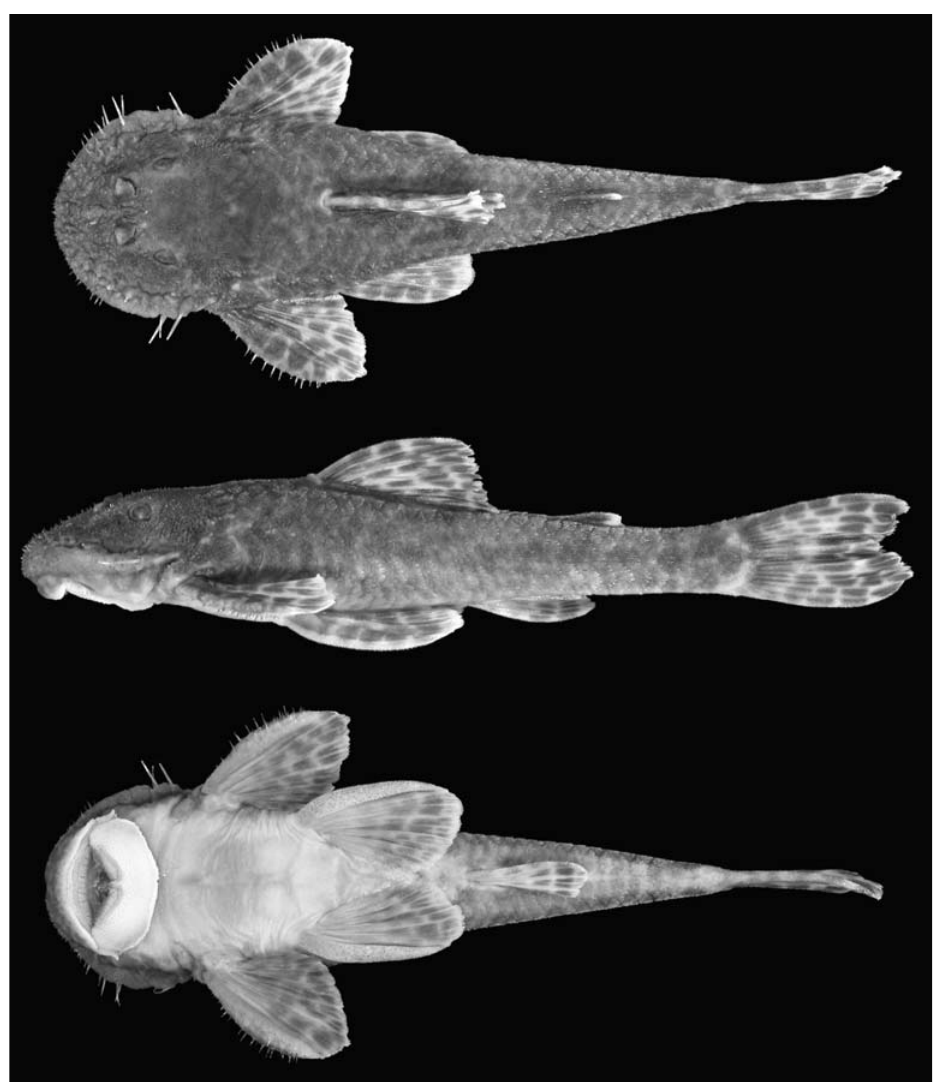
Fig. 1. Pareiorhaphis parmula , holotype, MCP 35826 male, 93.3 mm SL. Brazil: Paraná: Lapa: rio Iguaçu basin: rio dos Patos, tributary of rio da